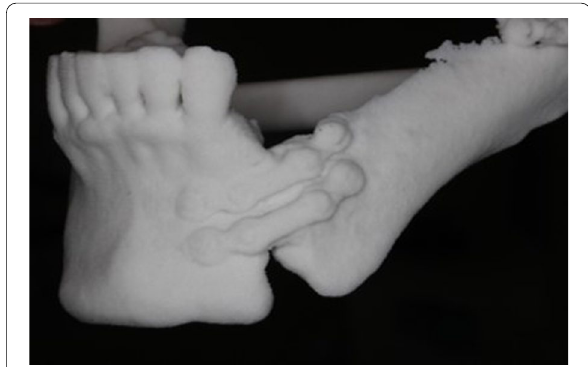
Fig. 3 Three-dimensional plaster model of the mandible before secondary bone reconstruction